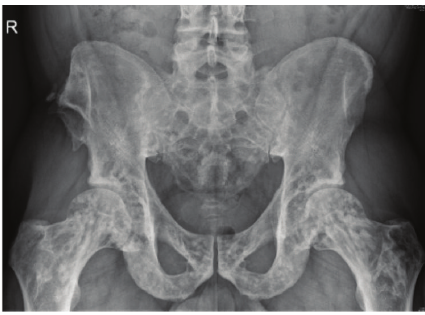
Figure 2: Radiograph of the pelvis showing multiple sclerosis lesions scattered in the pelvis and the upper end of the femur.